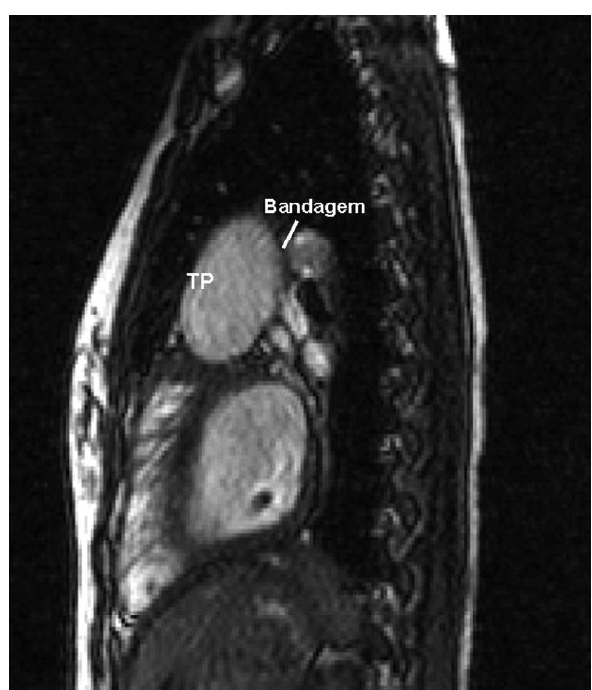
Fig. 2 – Aneurisma do tronco pulmonar e estenose de ramos pulmonares causados pela bandagem TP - Tronco